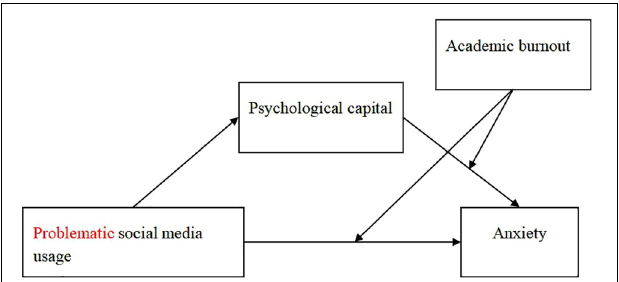
FIGURE 1 | The proposed moderated mediation